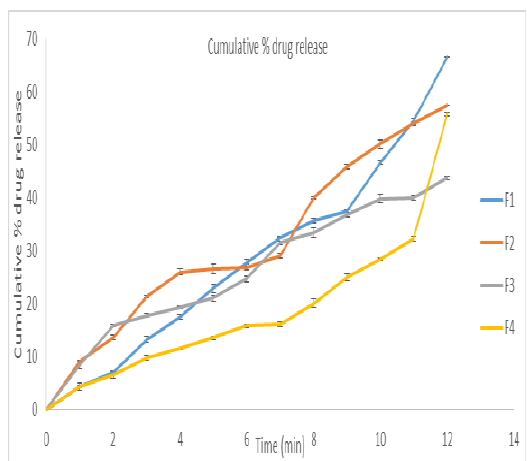
Figure 7. Drug release from F1 to F4